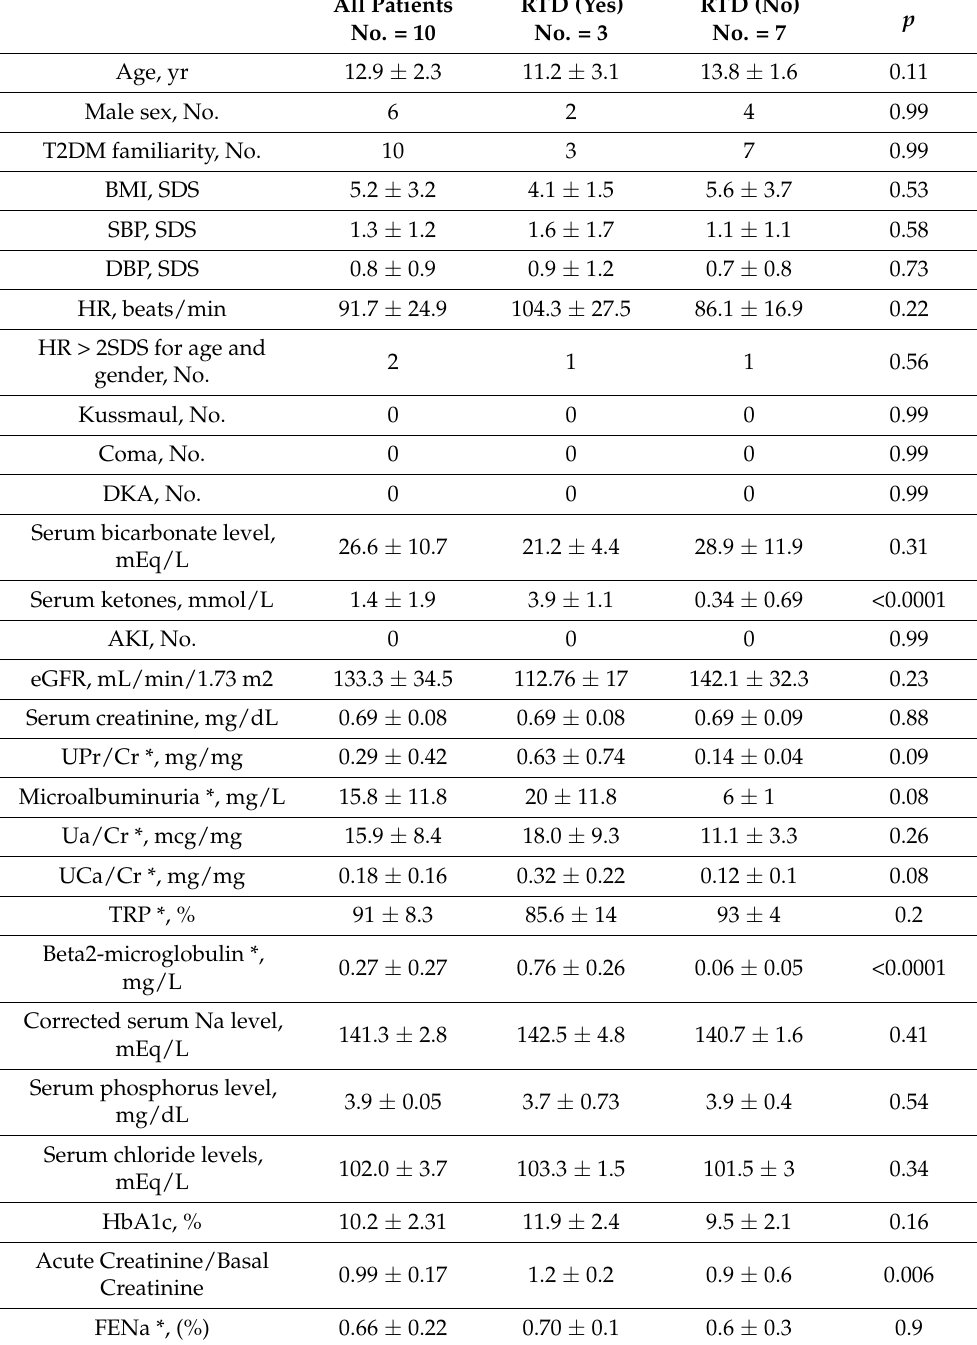
Table 1. Clinical and biochemical characteristics of all the enrolled patients and of the patients with and without RTD at T2DM